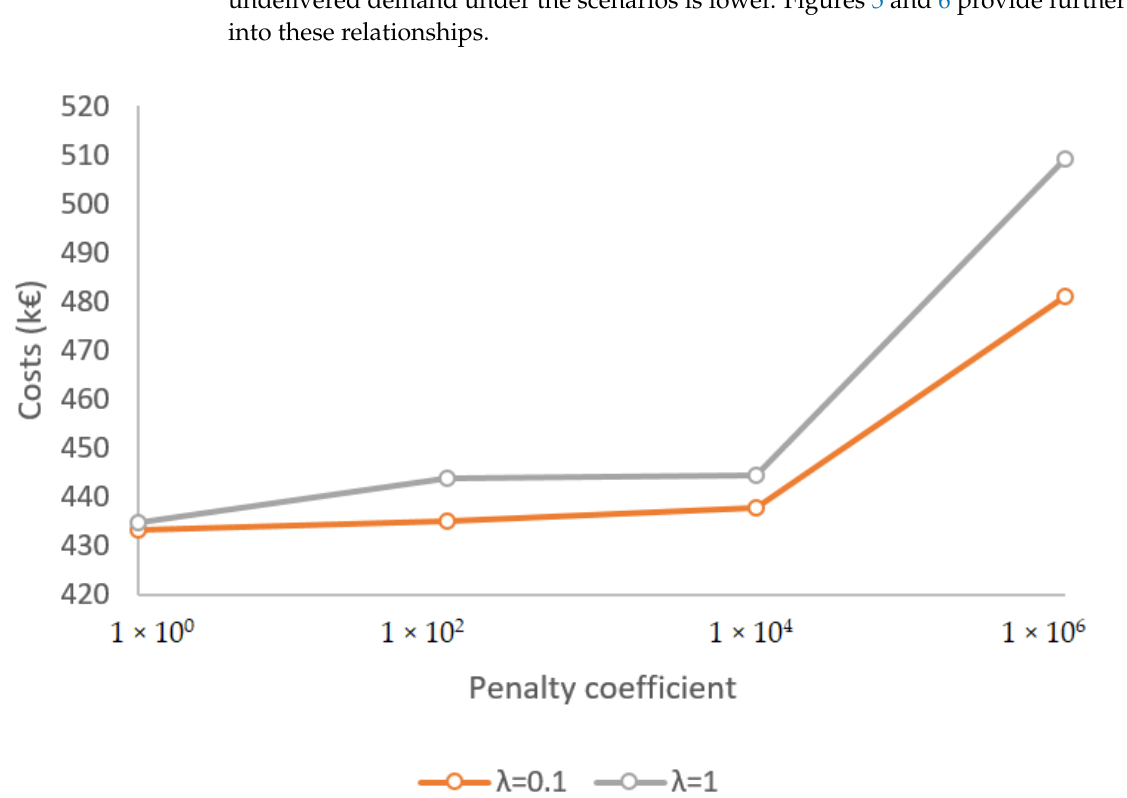
Figure 5. Relation between the design costs and the considered variance-factor ( λ ) and penalty coefficient (Cpen) in the optimization model (considering historic demand scenarios). The different colors indicate the considered variance-factor in the optimization model. The costs are higher for the higher variance-factor ( λ = 1).